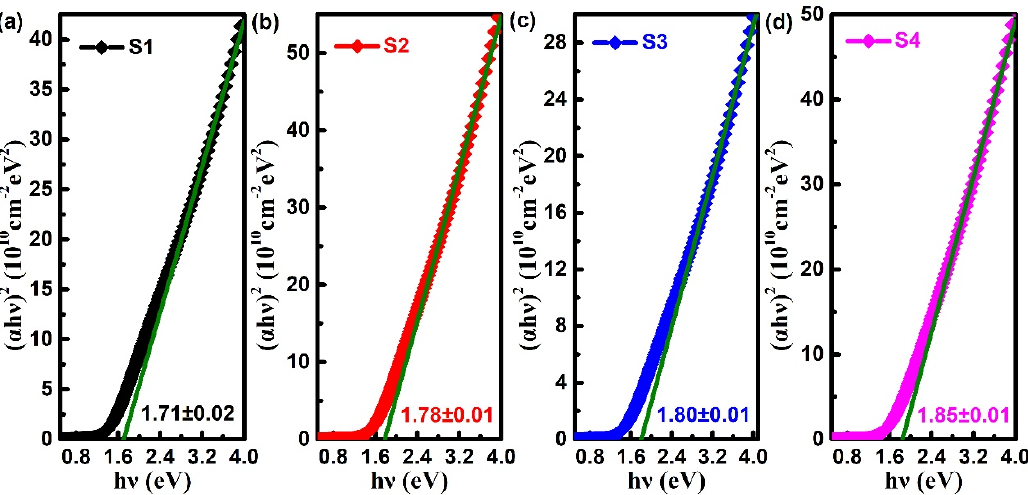
Figure 7. The optical band gaps of Ta-doped InTe thin films: ( a ) S1, ( b ) S2, ( c ) S3, ( d ) S4 .